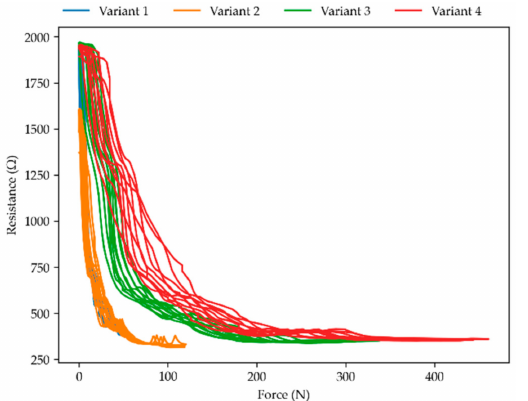
Figure 10. Resistance response upon force application for measurements with a gap of 0.3 mm at 10 mm/min.